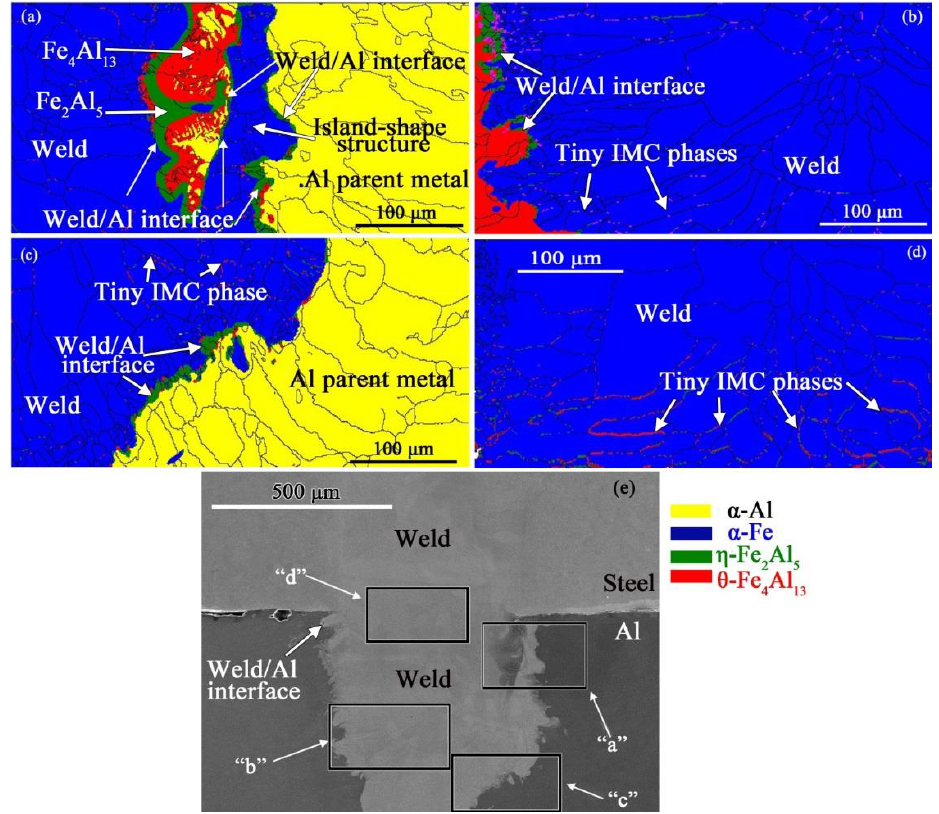
Figure 8. EBSD phase mapping images of the different zones in the steel/Al joints produced by dual-beam laser welding with side-by-side configuration: ( a ) Zone “a” marked in ( e ); ( b ) Zone “b” marked in ( e ); ( c ) Zone “c” marked in ( e ); ( d ) Zone “d” marked in ( e ); ( e ) Cross section of steel/Al joint and the locations of Zo nes “a–d”.